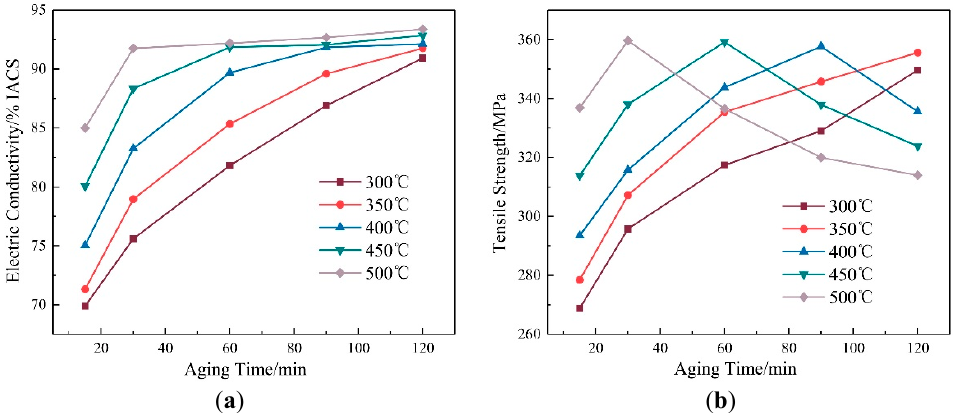
Figure 5. Property curves of the alloy with ageing time: ( a ) Electric conductivity; ( b ) tensile